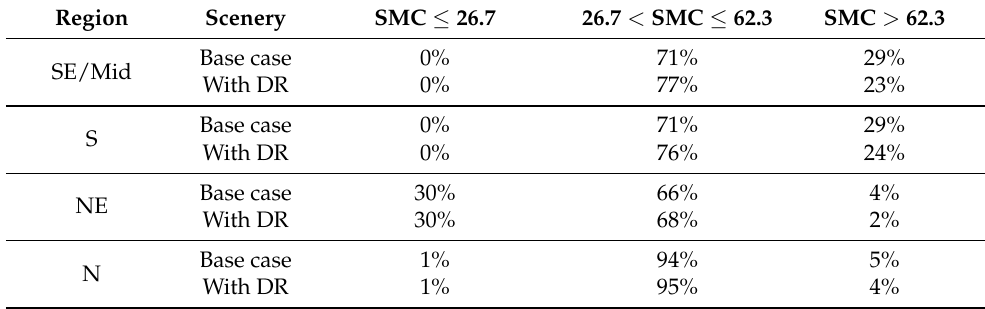
Table 3. Distribution of SMC values